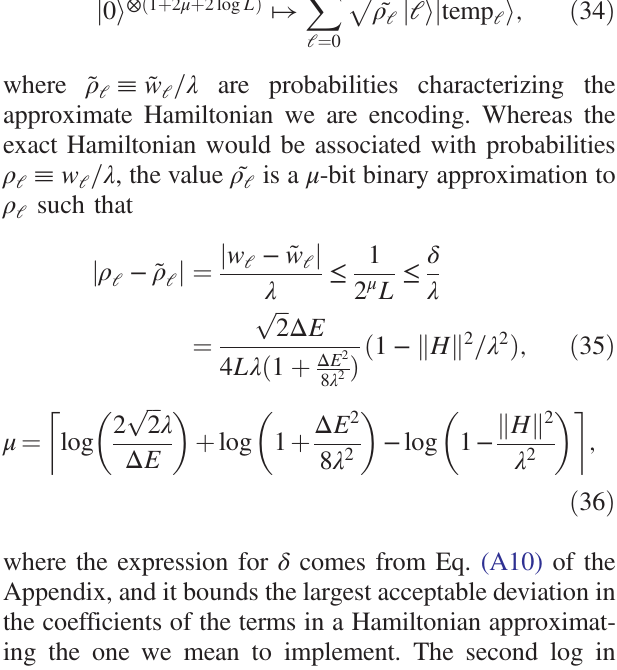
p ffiffiffiffiffiffiffiffiffiffi P L − 1 w l = λ j l l ¼ 0